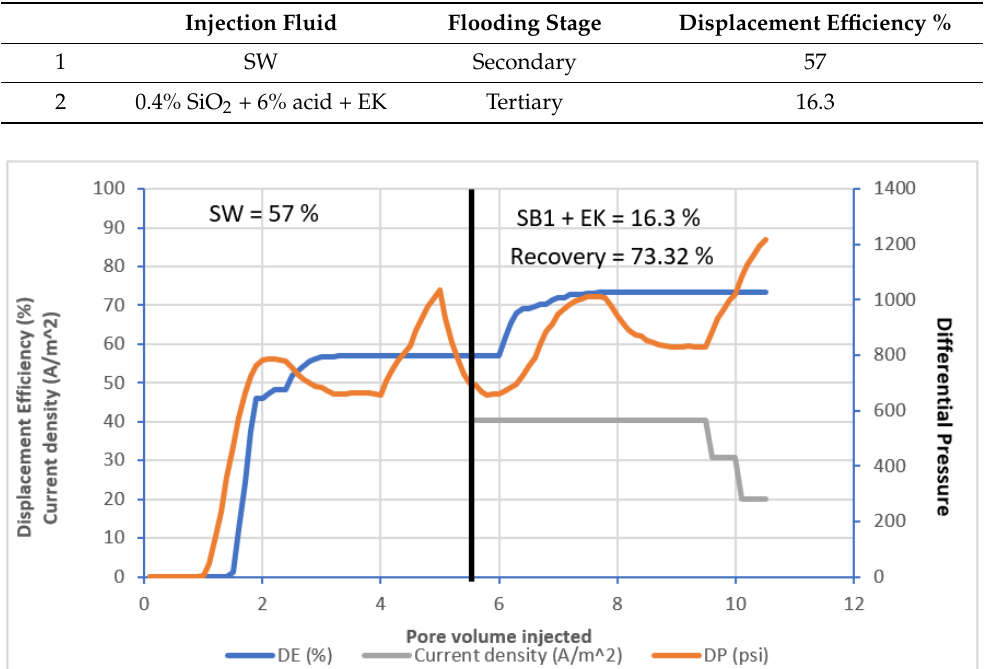
Table 16. Summary of CF9.